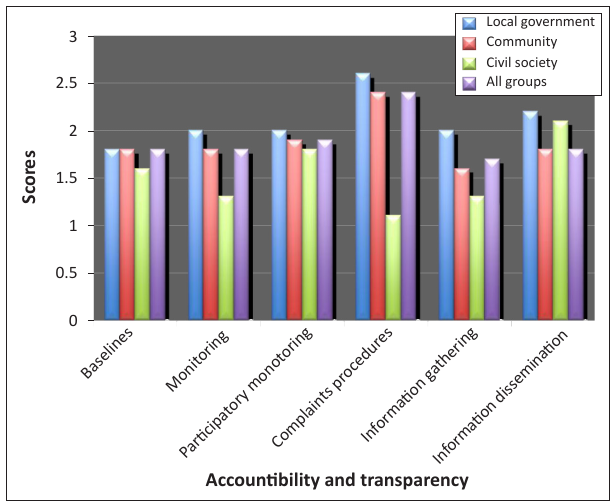
FIGURE 5: Overall mean scores for indicators on accountability and